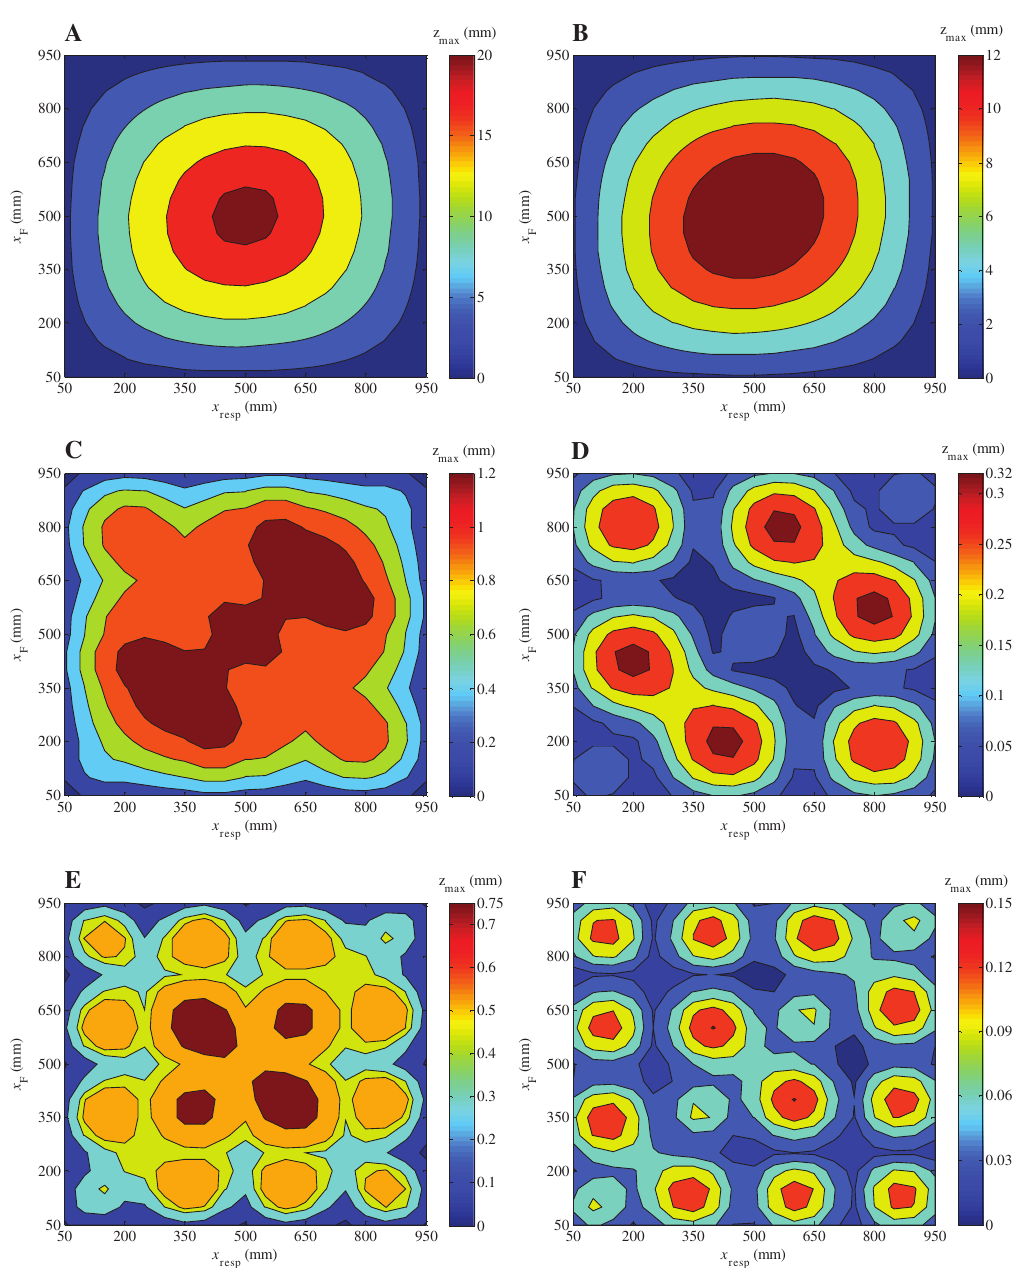
lay-up (A) 5 Hz, ζ = 0.0, (B) 5 Hz, ζ = 0.02, (C) 50 Hz, ζ = 0.0, s